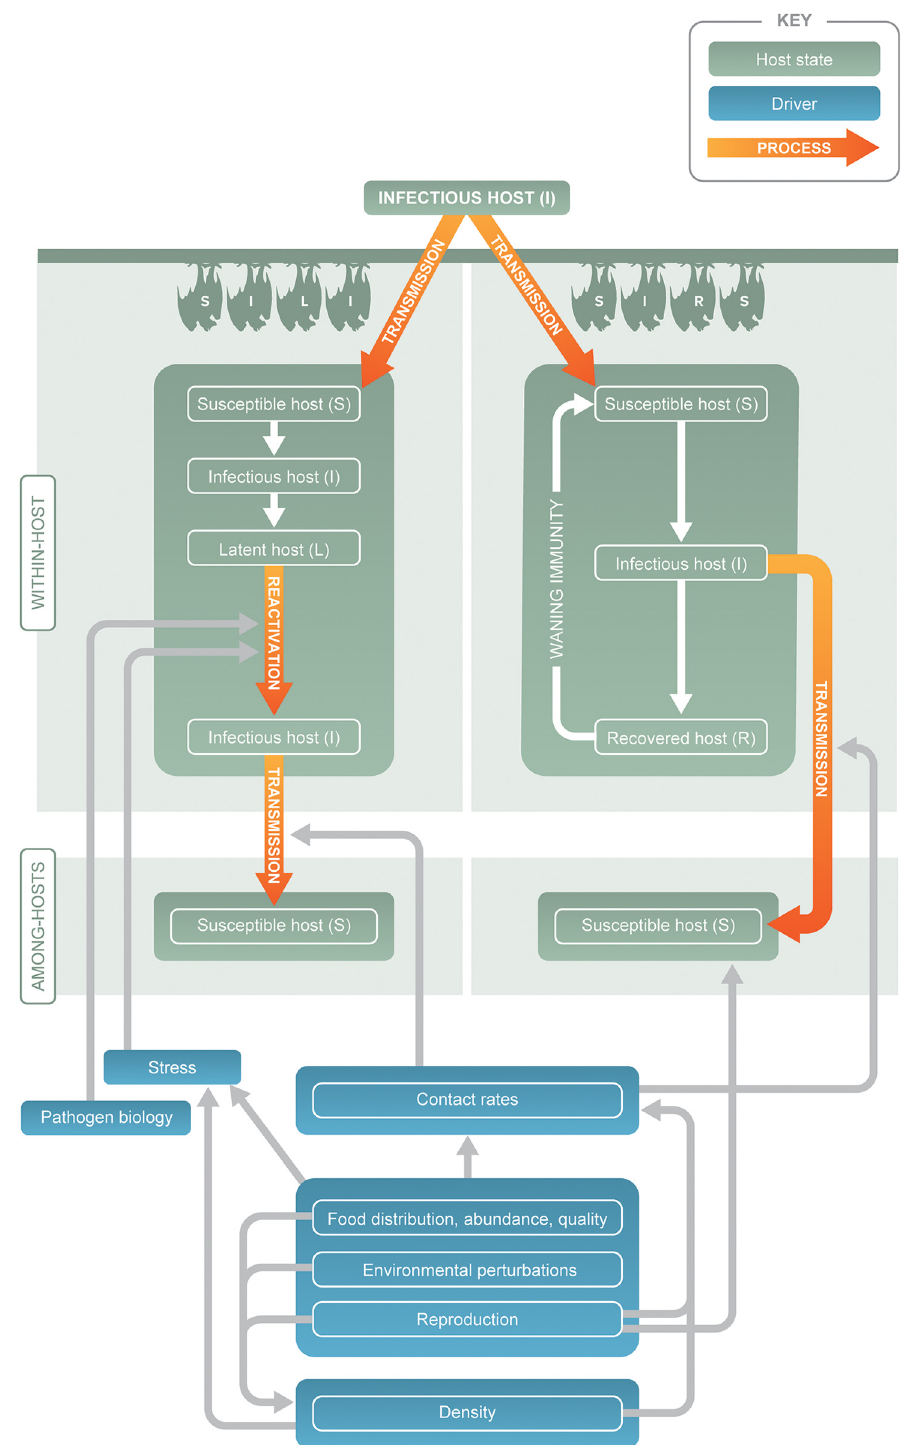
Fig 2. Drivers of disease dynamics within hosts, and within populations, given persistent infections with latency and reactivation (SILI dynamics) or immunizing infections with or without waning immunity (SIR or SIRS dynamics). A common factor among scenarios is seasonal forcing, which occurs through birth pulses, seasonal transmission, or periods of environmental or physiological stress. These factors affect SILI dynamics through reactivation and SIR or SIRS dynamics through